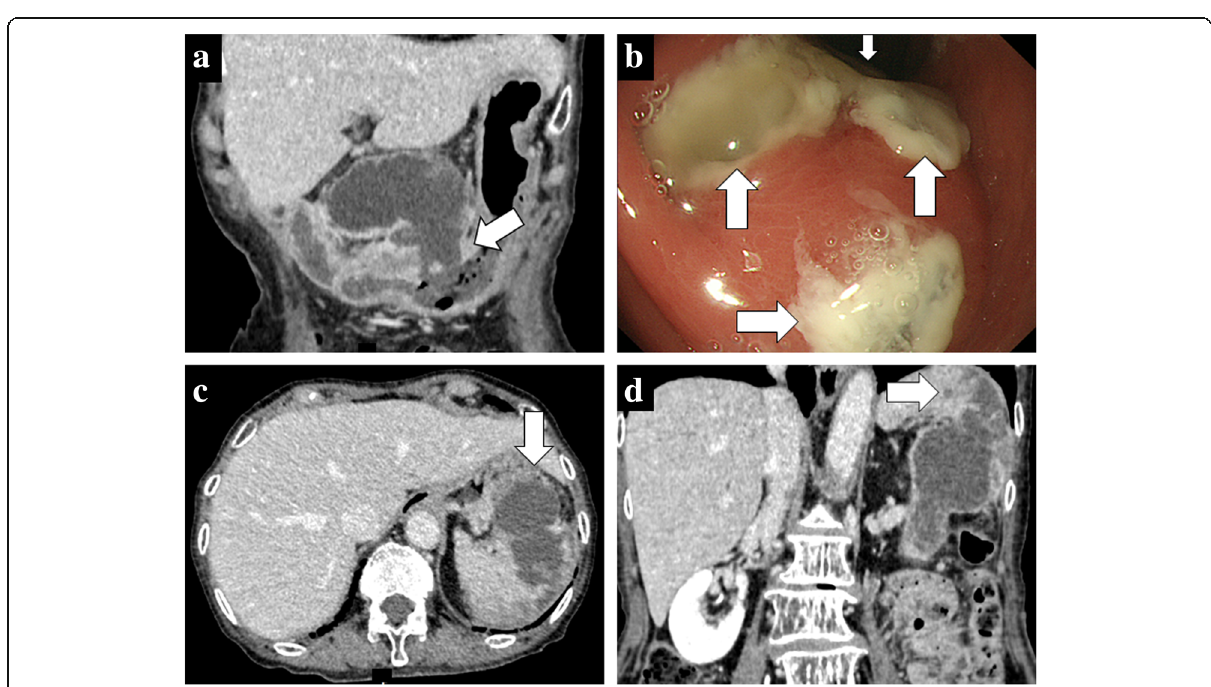
Fig. 2 Gastropancreatic fistula and splenopancreatic fistula. a Contrast-enhanced computed tomography (CT) revealed fistulas (white arrow) between the pancreas and stomach. b Upper gastrointestinal endoscopy revealed four gastropancreatic fistulas on the posterior wall of the gastric body (four white arrows) and mucus discharge from the gastropancreatic fistulas. c , d Contrast-enhanced CT revealed fistulas (white arrows) between the pancreas and spleen